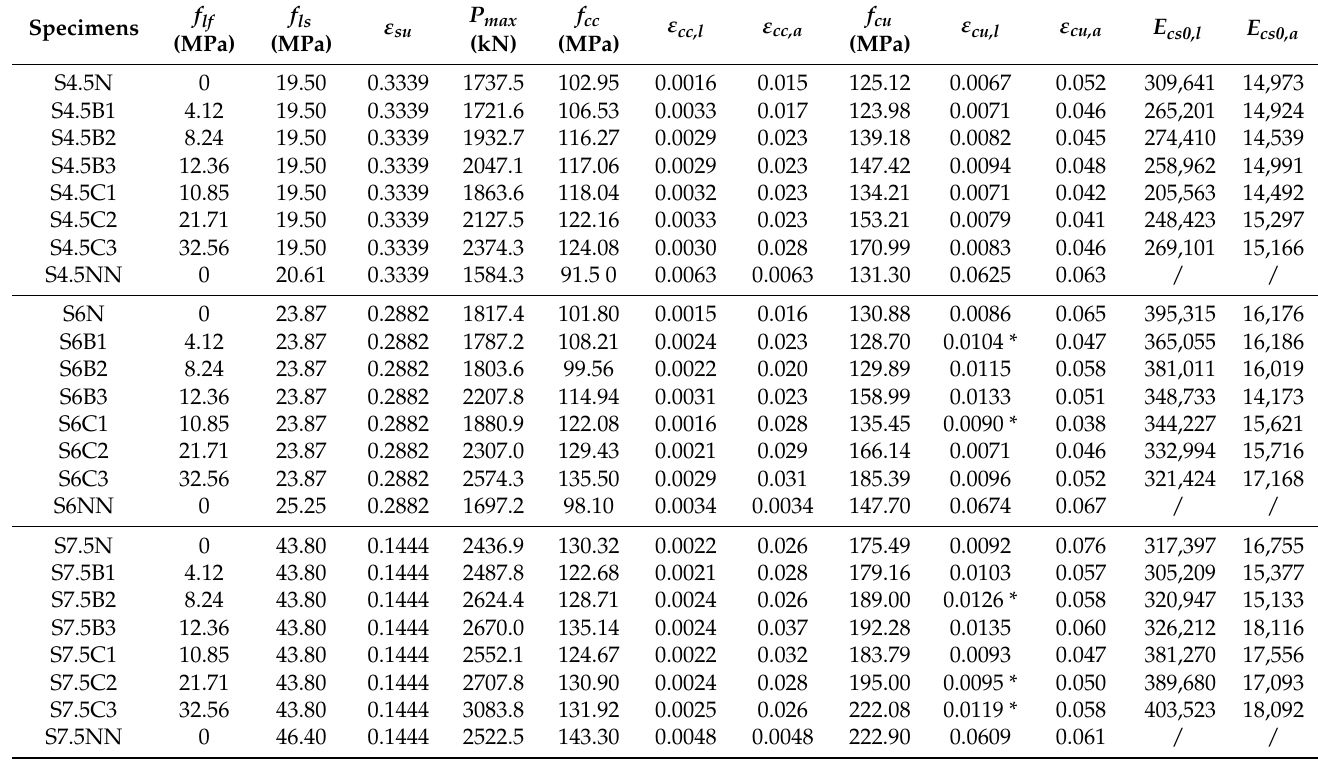
Table 3. Details of the test